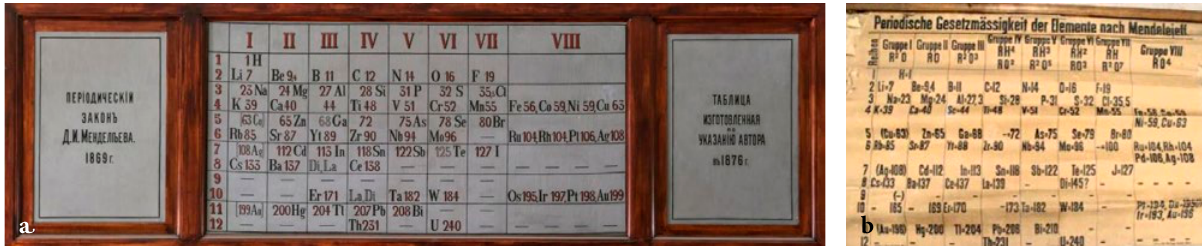
Figure 5. Two of the world’s oldest Periodic Table Charts: a - printed in 1876 and exposed in St. Petersburg University (Public domain); b - found at University of St. Andrews in Scotland by Dr. A.Aitken and printed in 1885 in Vienna (Public domain, photo St. Andres